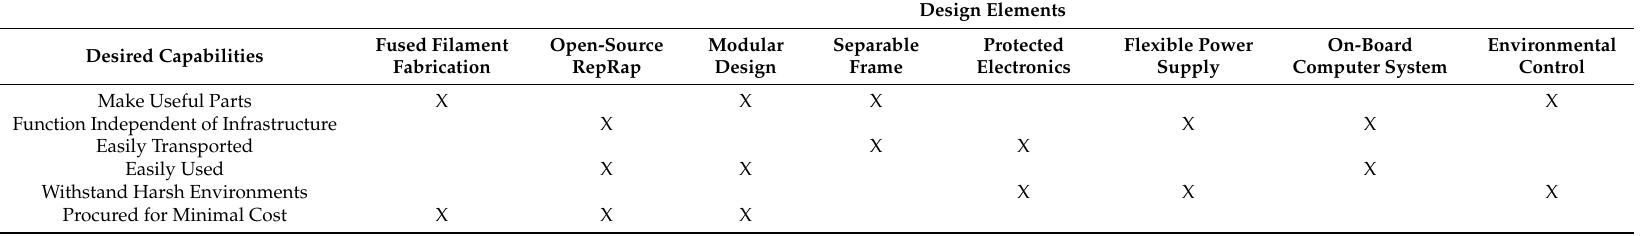
Table 1. Design elements for a humanitarian 3-D printer and how they relate to the desired design capabilities, an ‘X’ indicates that the design element better enables a corresponding